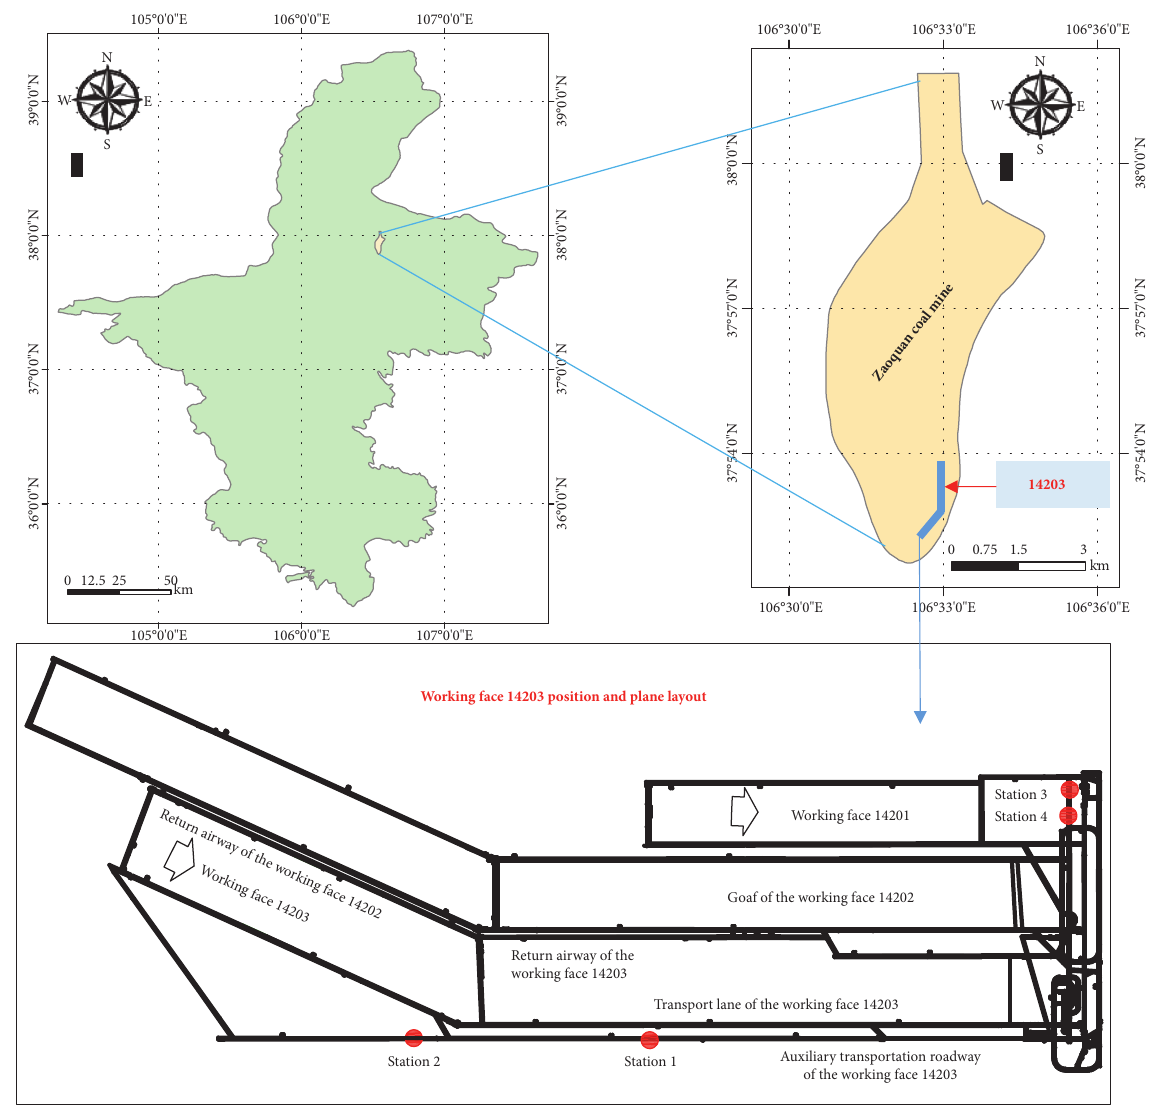
Figure 1: Position and plane layout of the working face 14203.